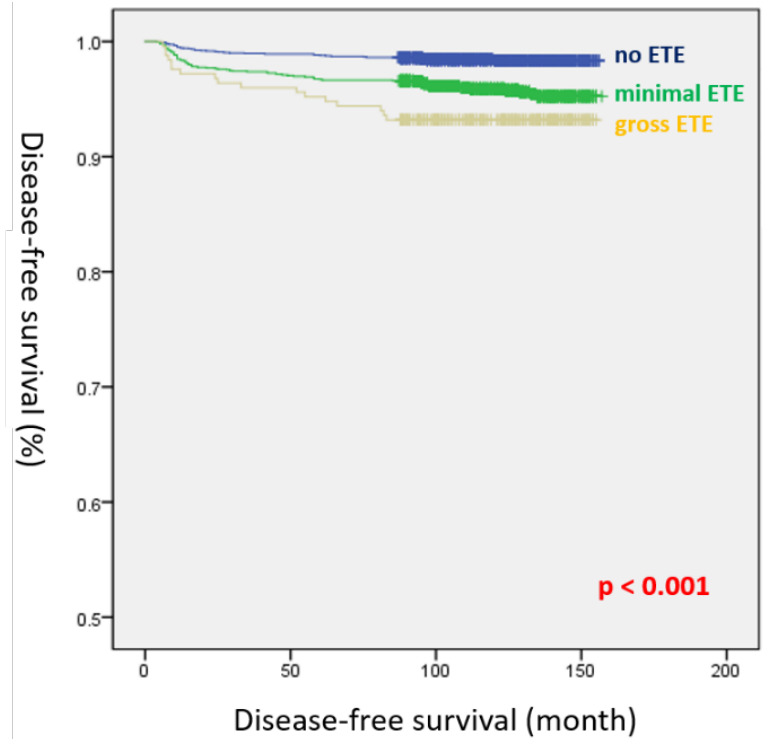
Figure 1. Disease-free survival curves of the three groups before propensity score matching (log-rank p < 0.001).